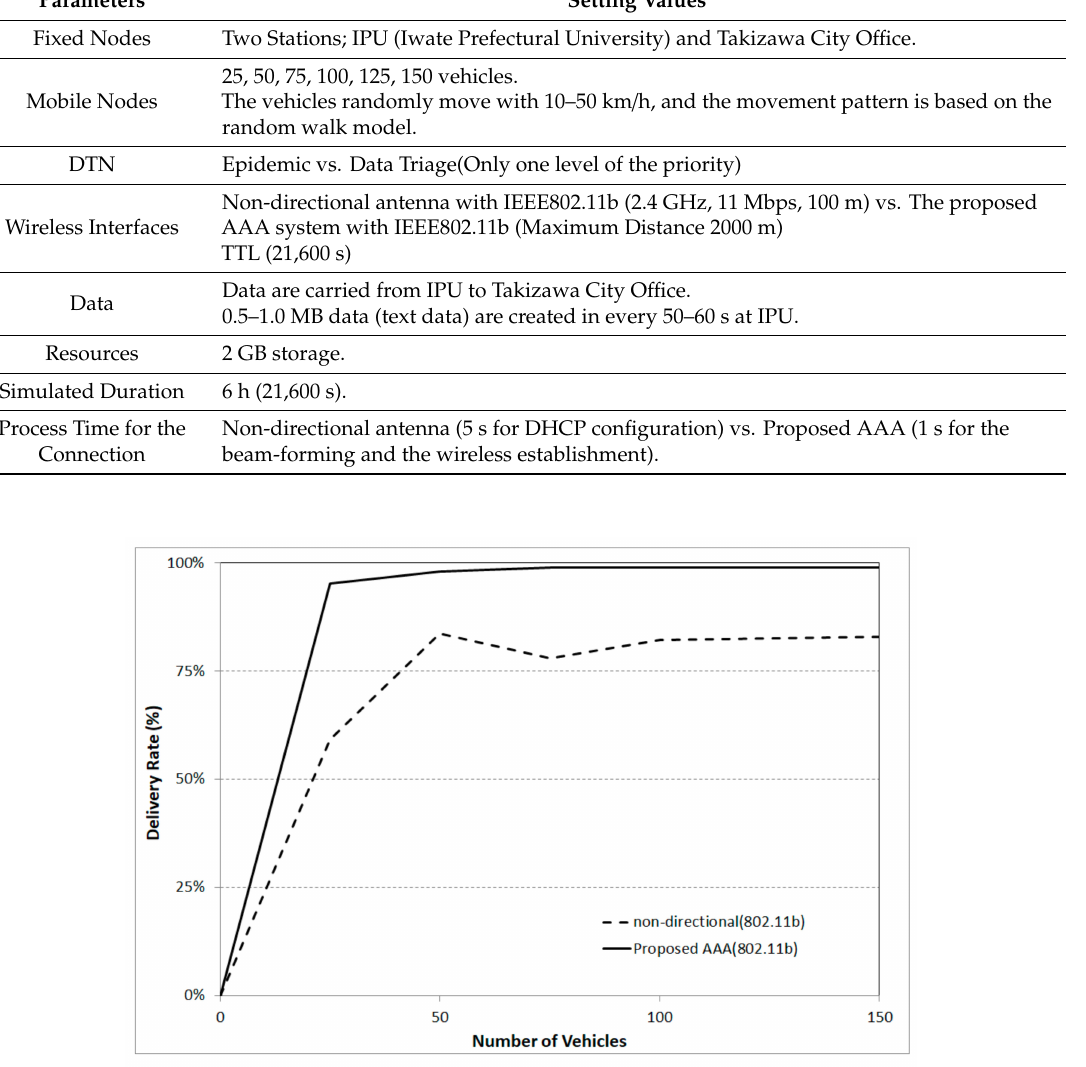
Figure 12. Results of the data delivery rate in the